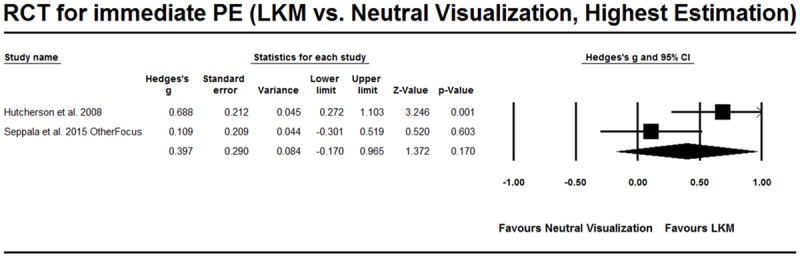
RCT studies for PE from on-going practice, comparison with neutral visualization. The highest estimation was based on prosocial positive emotion (OtherFocus) in Seppala et al. (2014).